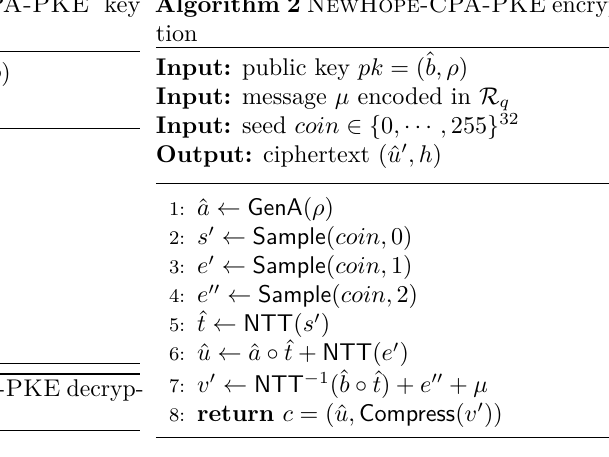
Algorithm 2 NewHope-CPA-PKE